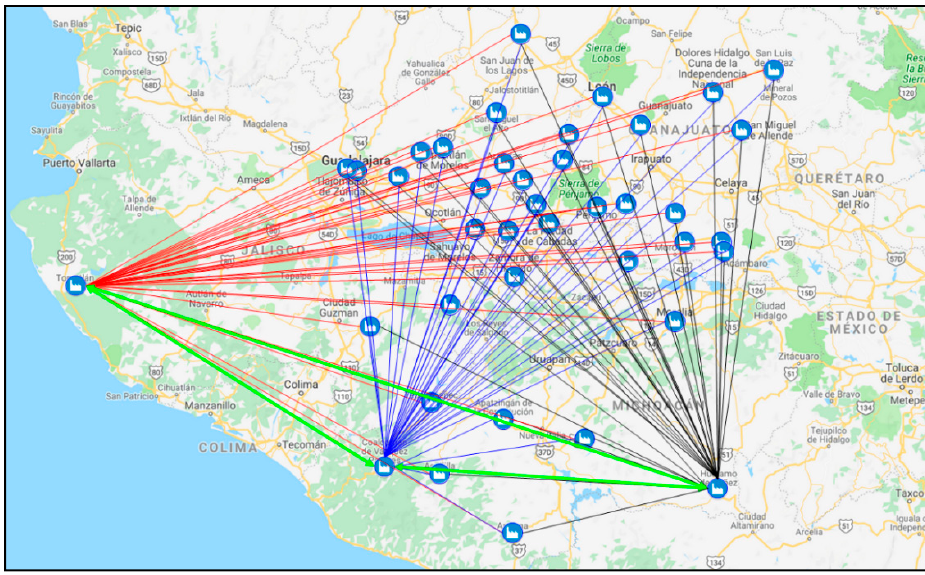
Figure 2. Different locations of biomass suppliers and potential localization of upgrading biogas technologies.